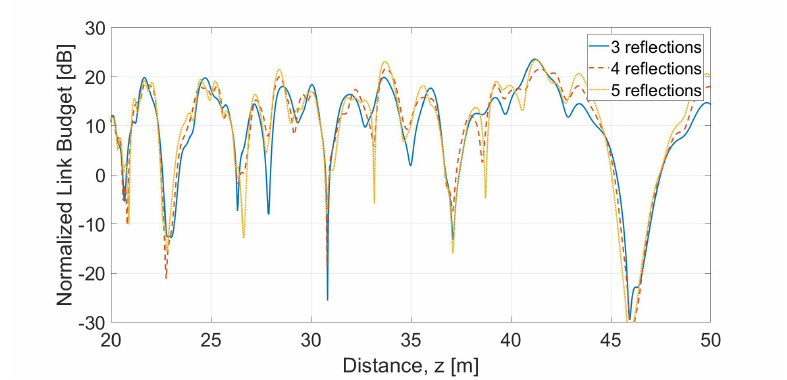
Figure 4. Overview of different numbers of reflected rays at 28 GHz.